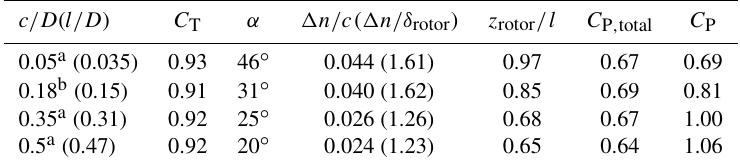
Table 1. The design variables for optimal C P , total .